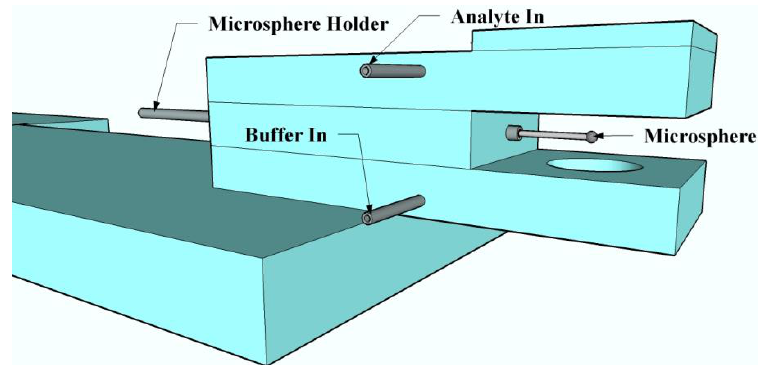
Figure 3. A model of the open-flow flow